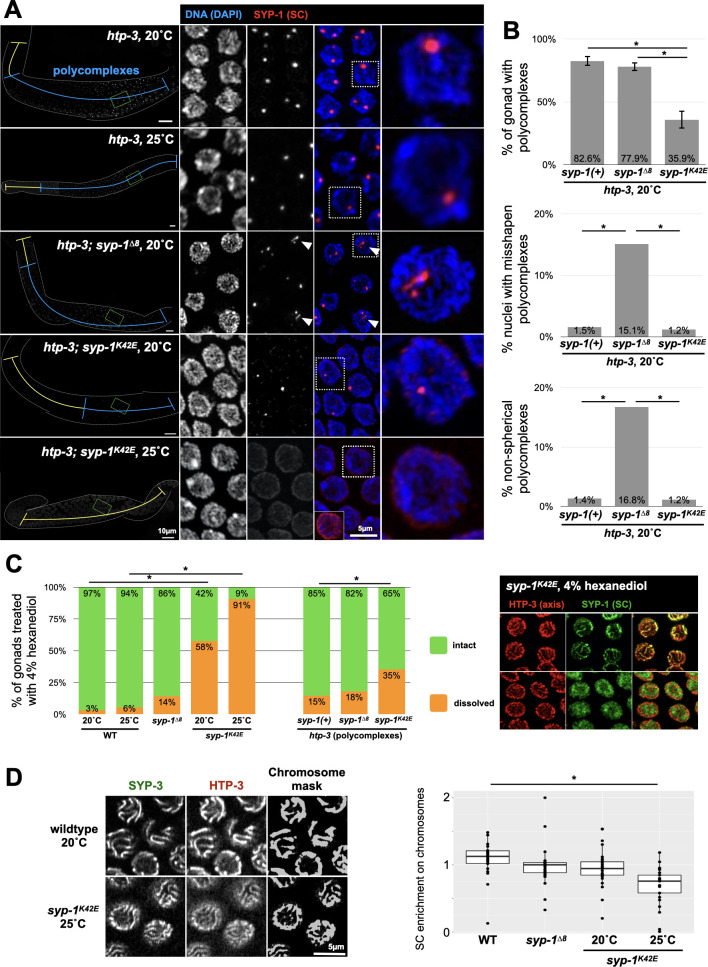
The N-terminus of SYP-1 plays a role in intra-SC interactions.A) Polycomplex morphology and dynamics are altered in htp-3 syp-1K42E and htp-3 syp-1Δ8 animals. Immunofluorescence images of gonads stained with anti-SYP-1 antibodies. The region of the gonad containing nuclei with polycomplexes is marked with a blue line, whereas the yellow line designates meiotic nuclei without polycomplexes. Scale bars = 10μm. Middle, pachytene nuclei, with a magnified nucleus shown to the right. SYP-1 polycomplexes are red and DAPI (DNA) is shown in blue. Misshapen polycomplexes (arrowheads) occur in htp-3 syp-1Δ8 animals. htp-3 syp-1K42E (25°C) harbor no polycomplexes; bottom left, over-exposed nucleus showing only diffuse SC staining. Scale bar = 5μm. B) Quantitation of polycomplexes in syp-1 mutants. Top, the portion of the gonad harboring polycomplexes. Error bars indicate standard deviations. N>4 gonads in each condition. Significant pairwise comparisons are indicated (Student’s t-test, p<0.0005). Middle, percentage of nuclei containing misshapen polycomplexes, scored manually. N>160 nuclei from three different gonads for each genotype. Significant pairwise comparisons are indicated (Pearson’s chi-squared test, p<0.0005). Bottom, non-spherical polycomplexes (ratio between the short and long axis of less than 0.5, where 1 represent a perfect sphere). N>80 polycomplexes from at least three gonads for each genotype. Significant pairwise comparisons are indicated (Pearson’s chi-squared test, p<0.0005). See S3A Fig for additional data. C) Assembled SC and polycomplexes in syp-1K42E animals are hypersensitive to dissolution by 4% 1,6-hexanediol. Left, percentage of gonads from the indicated genotypes where the SC was dissolved with 4% 1,6-hexanediol. Middle, percentage of gonads from the indicated genotypes where polycomplexes were dissolved with 4% 1,6-hexanediol. N>30 gonads for each condition. Significant pairwise comparisons to wild type or syp-1(+) are indicated (Pearson’s chi-squared test, p<0.05). Right, immunofluorescence images of representative nuclei with intact SC (chromosome associated, top) and dissolved SC (diffuse nucleoplasmic, bottom) in pachytene nuclei from syp-1K42E (20°C) animals. D) syp-1 mutants affect the enrichment of the SC on chromosomes versus nucleoplasm. Left, representative nuclei from wild-type and syp-1K42E (25°C) animals expressing GFP-SYP-3 and HTP-3-wrmScarlet. A chromosome mask was calculated based on HTP-3-wrmScarlet (see Methods for details). Right, the enrichment ratio was calculated by dividing the sum GFP-SYP-3 intensity inside the chromosome mask by the sum intensity outside the mask, and normalizing by the enrichment value for HTP-3-wrmScarlet. The bars indicate the median enrichment, and the boxes indicate the middle 50%. N>30 nuclei, from at least three animals, for each condition. Significant comparisons to wild type are shown (p<0.0001; Student’s t-test).